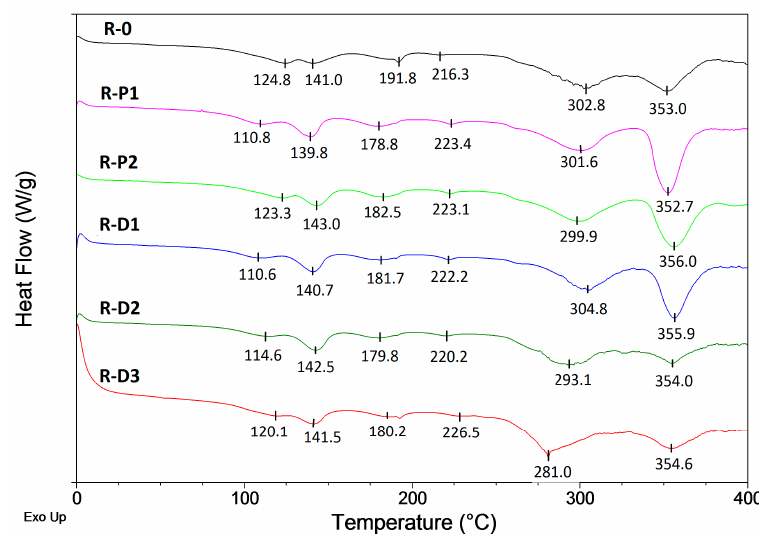
Figure 3. DSC curves for PER and PER-CNTs solid dispersions.